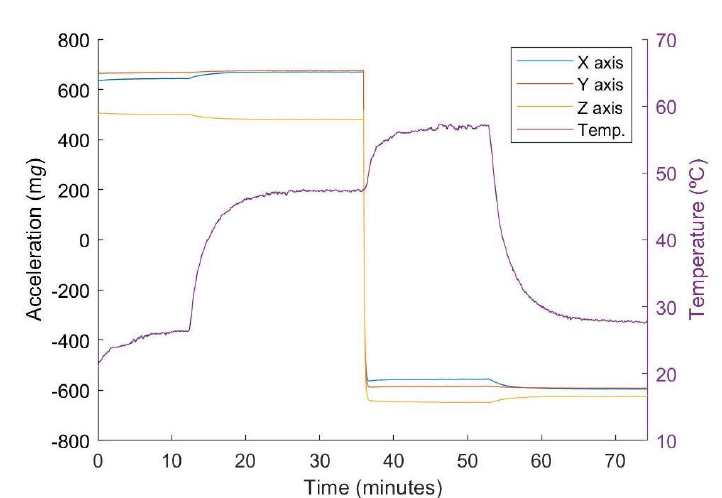
Figure 8. Acceleration and temperature values during the proposed calibration